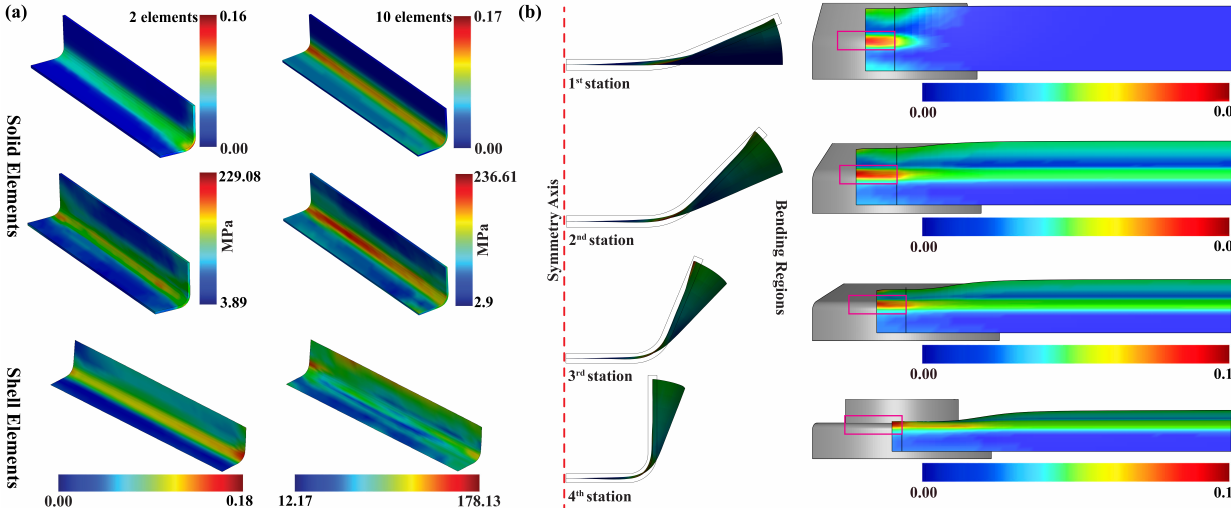
Figure 7. Sheet blank deformation during the roll forming process considering solid and shell elements ( a ) numerical results of solid and shell elements; ( b ) sheet deformation at each forming